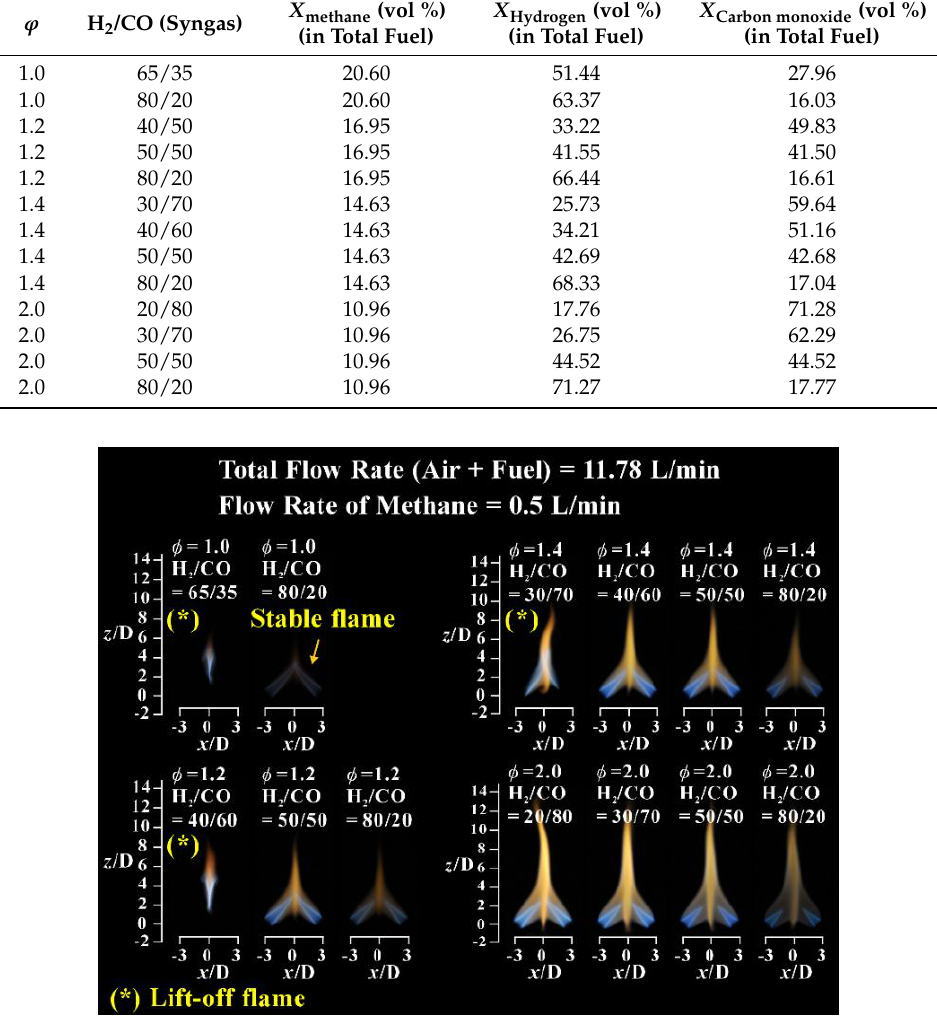
Figure 3. Typical flame patterns of the CH 4 /syngas/air premixed impinging flame.